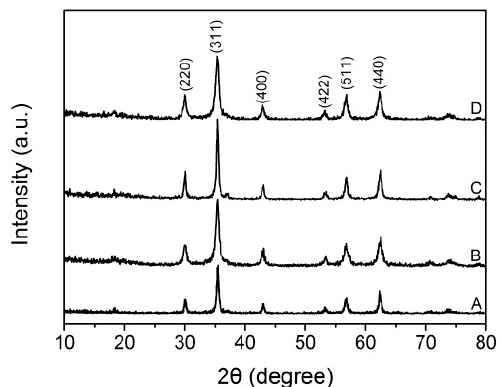
Figure 3. X-ray diffraction (XRD) patterns of ZnFe 2 O 4 CNAs: ( A ) CNA1; ( B ) CNA2; ( C ) CNA3 and ( D ) CNA4.